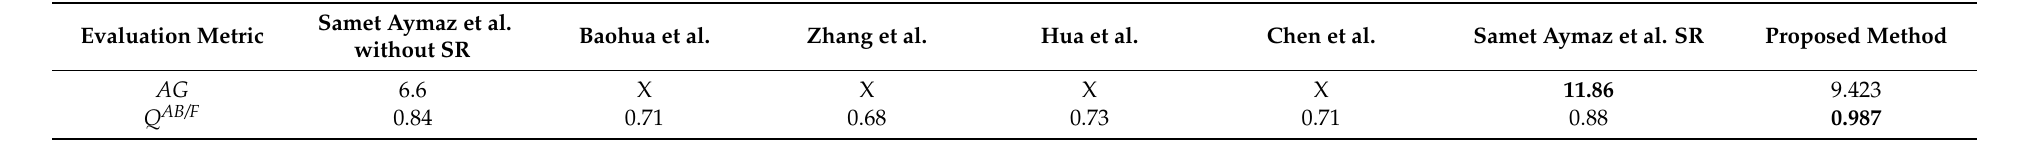
Table 12. The outcomes for the desk image and comparisons with existing techniques in the litera- ture ([25]).